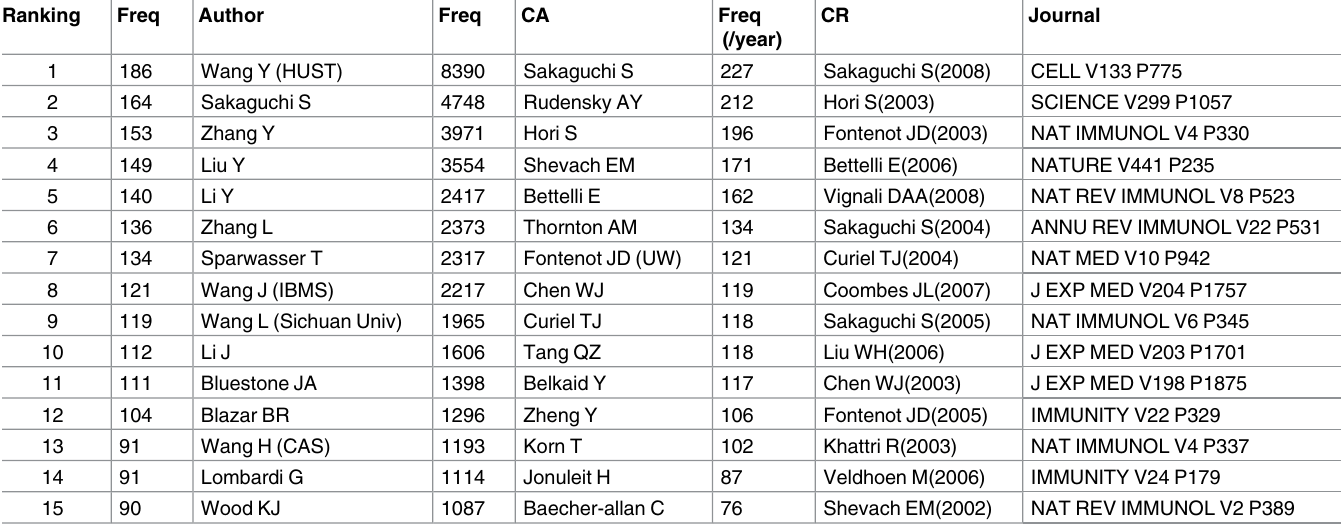
Table 4. The 15 most active Authors, Cited-Authors and Cited